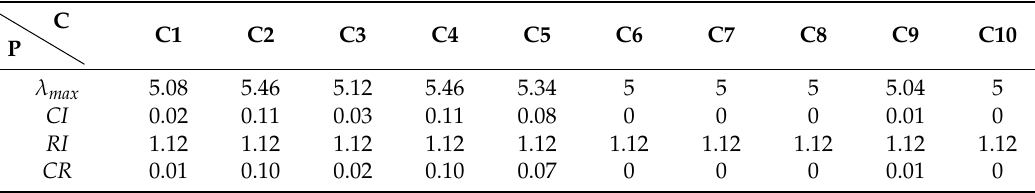
Table 9. Display of maximum values of comparison matrix ( λ max ), consistency index ( CI ), random index ( RI ) and consistency rate ( CR ) for analyzed tailing